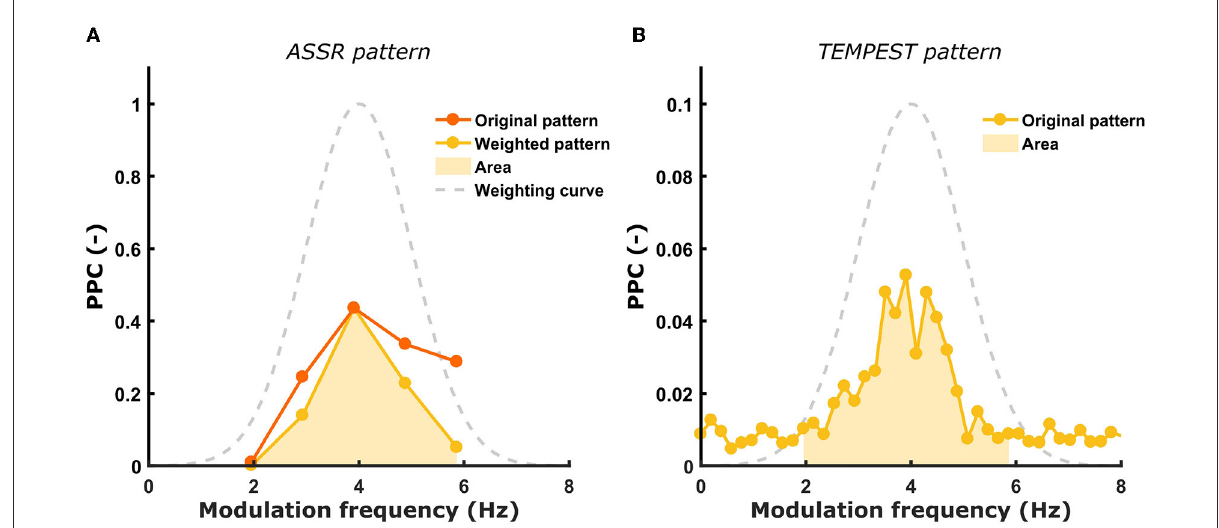
FIGURE3 Illustration of ASSR pattern weighting and computation of the area under the curve. (A) the original ASSR pattern is weighted by the Gaussian modulation distribution of the corresponding TEMPEST stimuli. The computed area under the weighted ASSR pattern is depicted as the shaded area. (B) The computed area under the TEMPEST pattern is depicted as the shaded area. Syllabic-like pattern data came from the left hemispheric channel in Participant